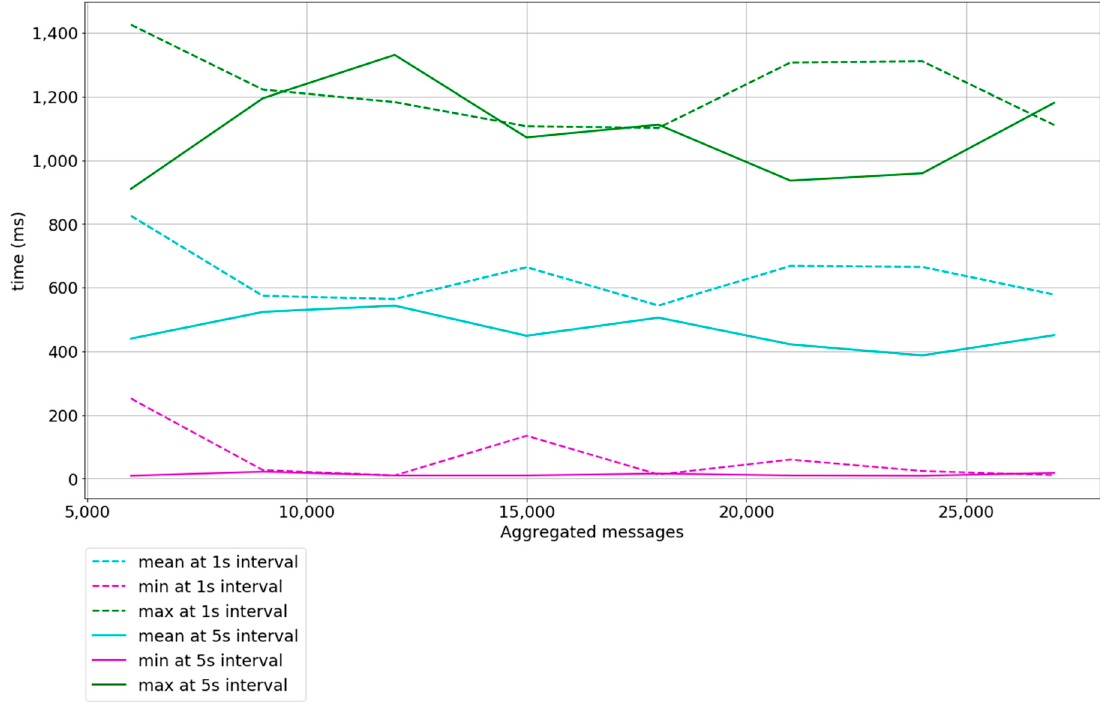
Figure 10. Results in experiment description setting 2 at 1 and 5-s interval between bursts. Dashed lines represent experiments at a 1-s interval between bursts and continuous lines represent experiments at a 5-s interval between bursts. Cyan lines represent the mean timedelta, magenta lines represent the minimum timedelta, and lines in green represent the maximum timedelta.